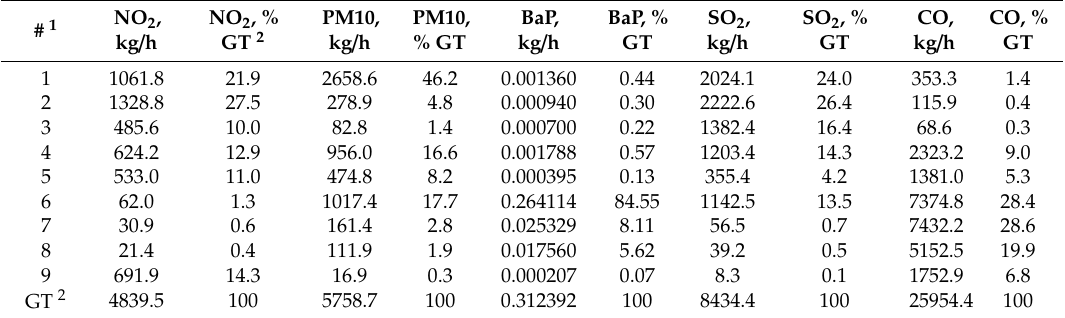
Table 5. The groups of sources and emission parameters in kg / h and % of gross total